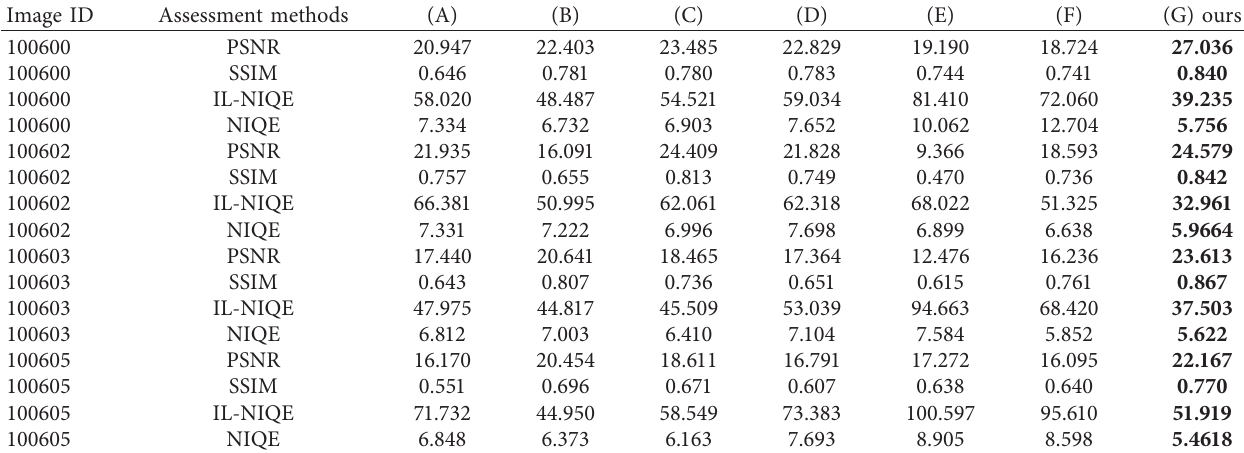
Table 5: The test results of objective IQA methods between our algorithm and deep underwater image enhancement. Image ID Assessment